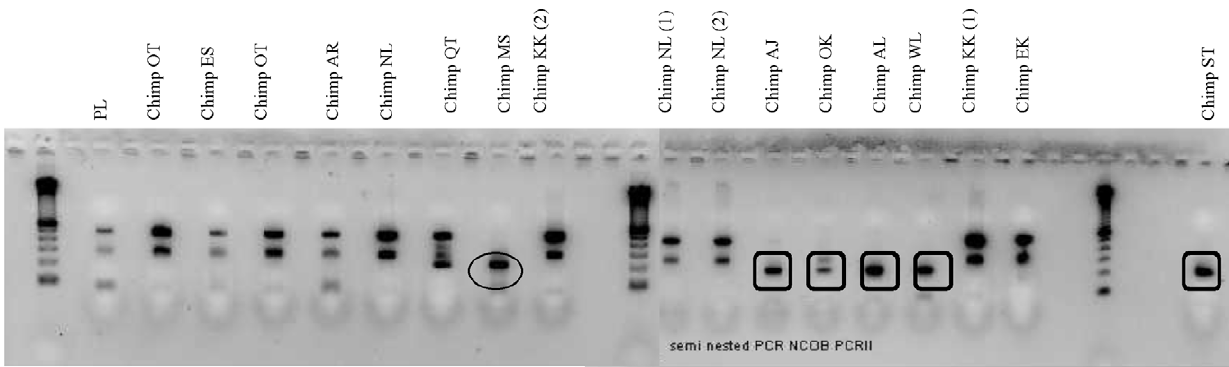
Figure 2. Semi-nested PCR and direct sequencing on DNA extracted from 16 coprocultured samples of 13 wild chimpanzees (see identity in Figure 1). Two different samples from NL and from KK were analysed, one sample from OK has been tested twice. Circle: Oesophagostomum stephanostomum products sequenced; square: Oesophagostomum bifurcum products sequenced. Control with Panagrolaimus larvae (PL).